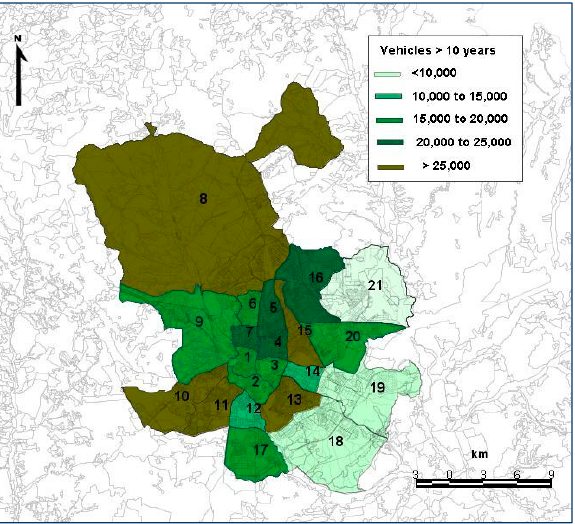
Figure 5. Average number of vehicles aged 10 years or more in the period 2013–2019 in each district of Madrid. Source: Own elaboration, based on the data drawn from the statistical information de-